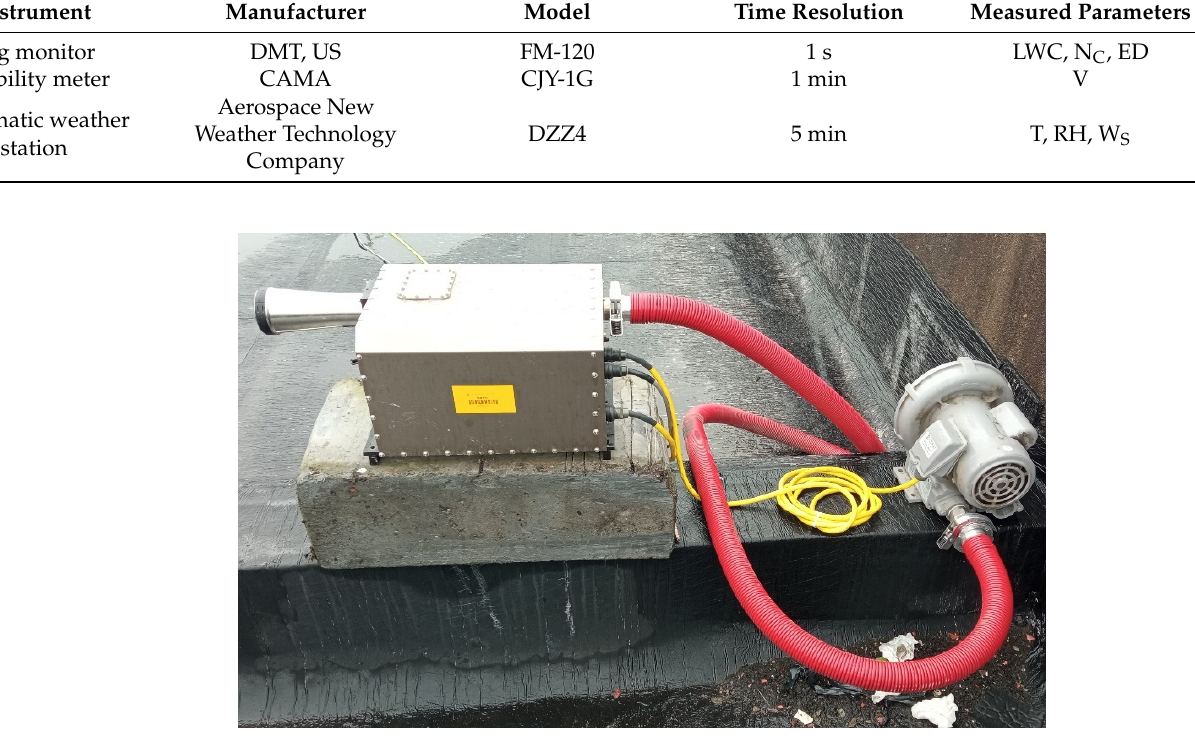
Figure 3. The actual installation of the FM-120 fog monitor. Table 1. Observation equipment and related technical parameters.